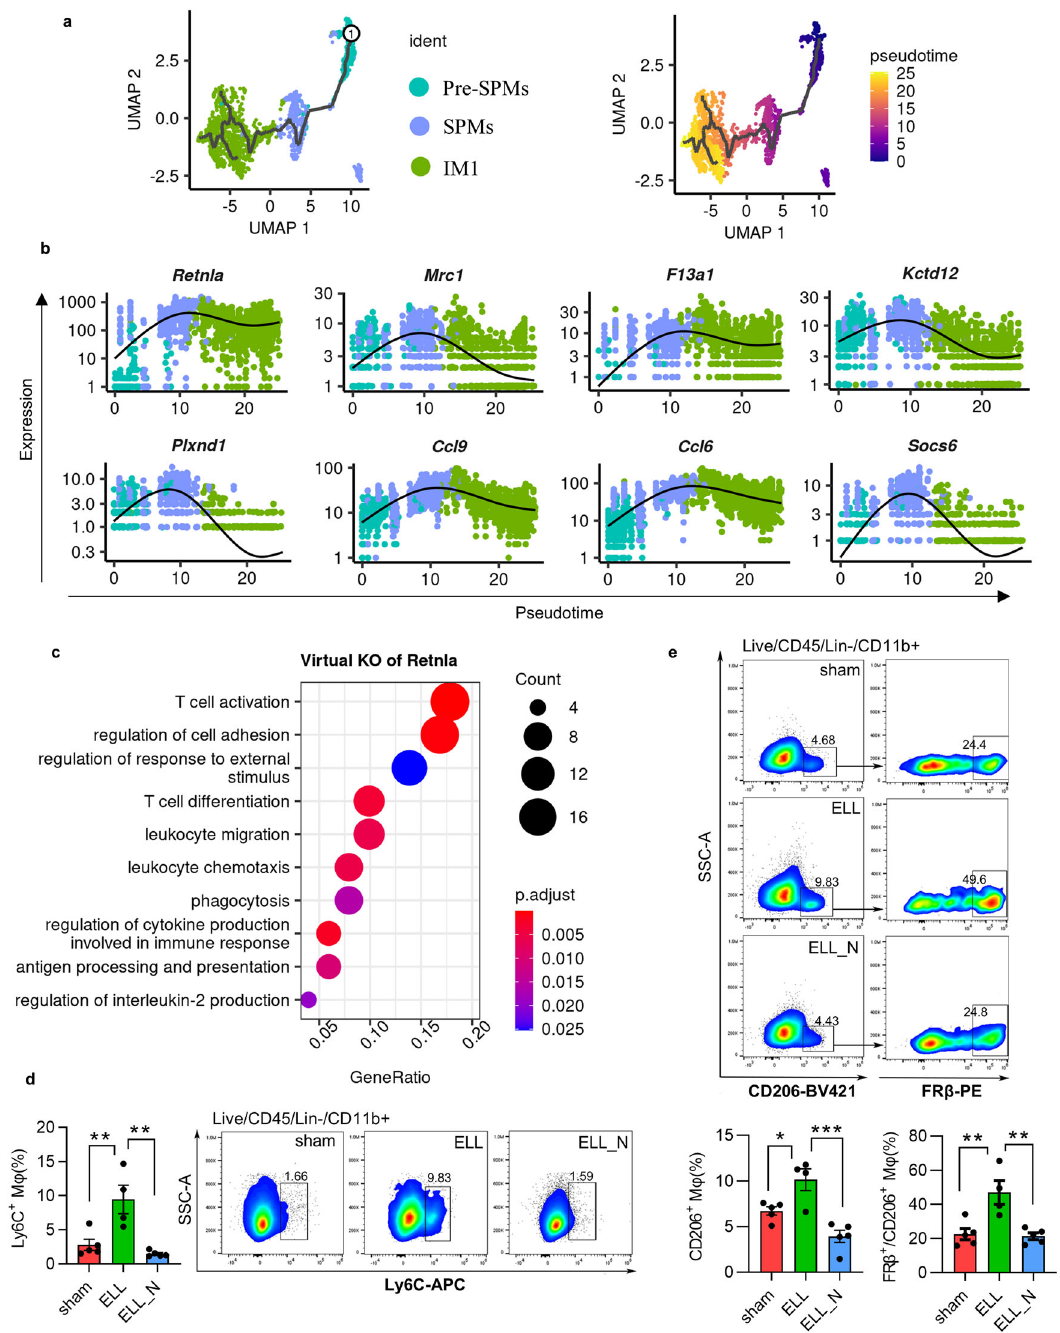
Fig. 4 Reconstruction of a pseudo-temporal trajectory for the early maturation and differentiation of recruited macrophages. a UMAP shows selected cells of recruited macrophages (left) and a trajectory path built by Monocle 3 (right). The selected root cell was labelled as ① . b Dynamic changes of genes along this trajectory path of differentiation. c GO terms of biological processes that were enriched by perturbed genes affected by virtual KO of Rentla . d Flow cytometer isolation and quanti fi cation of Ly6C + recruited monocytes. e Flow cytometer results and quanti fi cation of CD206 + and FR β + macrophages. * p < 0.05, ** p < 0.01, *** p < 0.001, mean ± SEM, n = 5 per